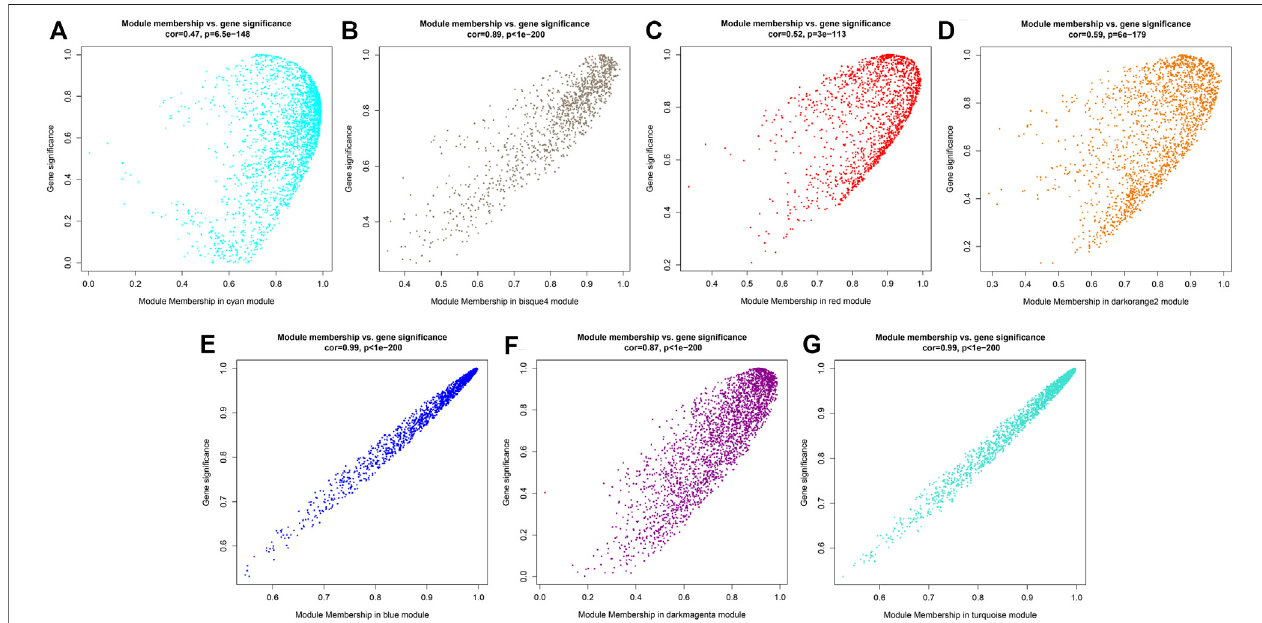
FIGURE 8 | Gene signi fi cance map. (A) Gene signi fi cance map for members of module MEcyan. (B) Gene signi fi cance map for members of module MEbisque4. (C) Genesigni fi cance map for members ofmodule MEred. (D) Genesigni fi cance map for members ofmodule MEdarkorange2. (E) Genesigni fi cance map for members of module MEblue. (F) Gene signi fi cance map for members of module MEdarkmagenta. (G) Gene signi fi cance map for members of module MEturquoise.